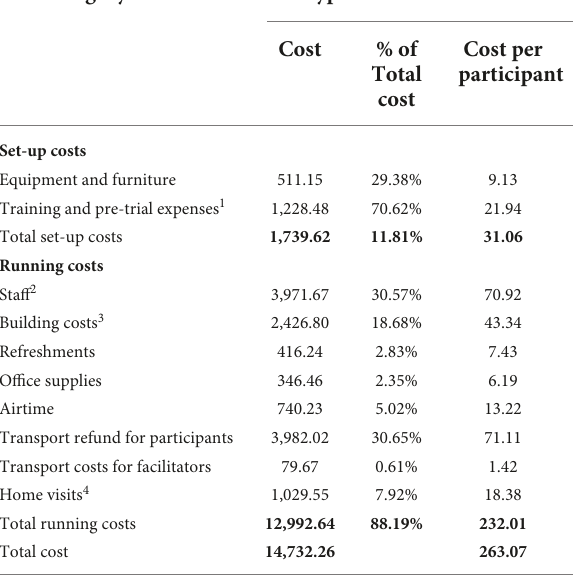
TABLE 3 Program provider economic costs in 2022 US Dollars (USD) ( n =